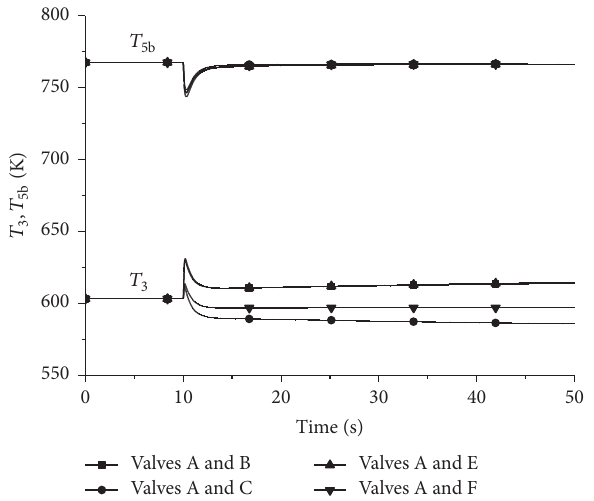
Figure 8: Gas temperature transients at reactor inlet (𝑇 3 ) and recuperator high-pressure side inlet (𝑇 5